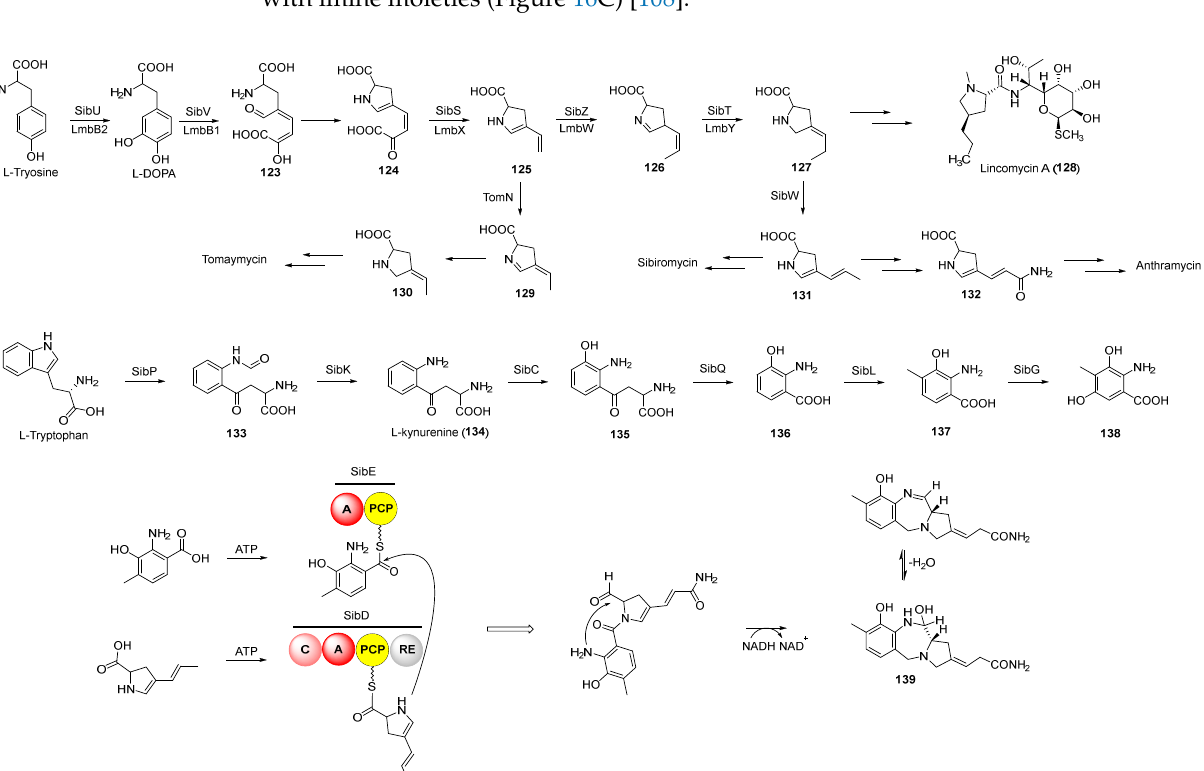
Figure 15. ( A ) Origins of pyrrolobenzodiazepines revealed by isotopic labeling experiments. ( B ) Chemical structure of SJG-136. ( C ) Proposed mechanism of DNA alkylating by pyrrolobenzodi- azapines.